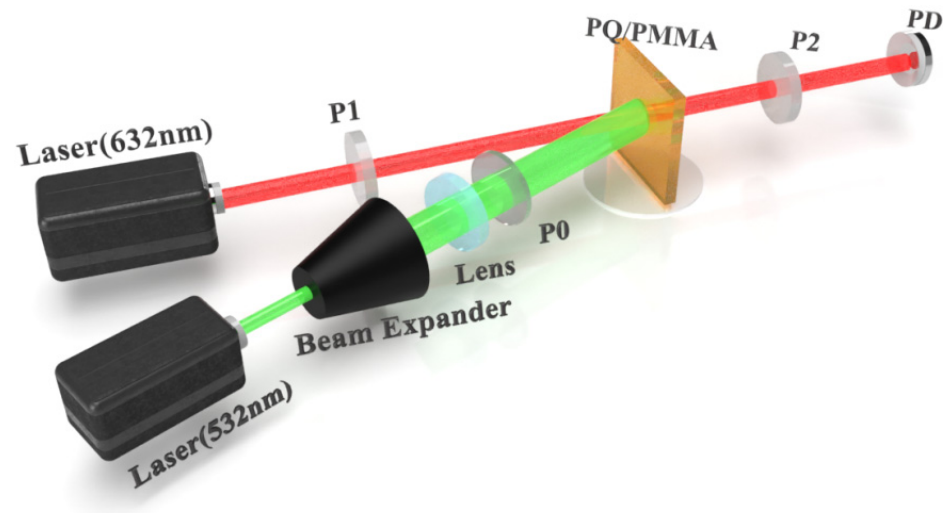
Figure 15. Experimental setup of photoinduced birefringence measurement. P0, P1, and P2 stand for the horizontal polarizer, the negative 45 ◦ polarizer, and the positive 45 ◦ polarizer,